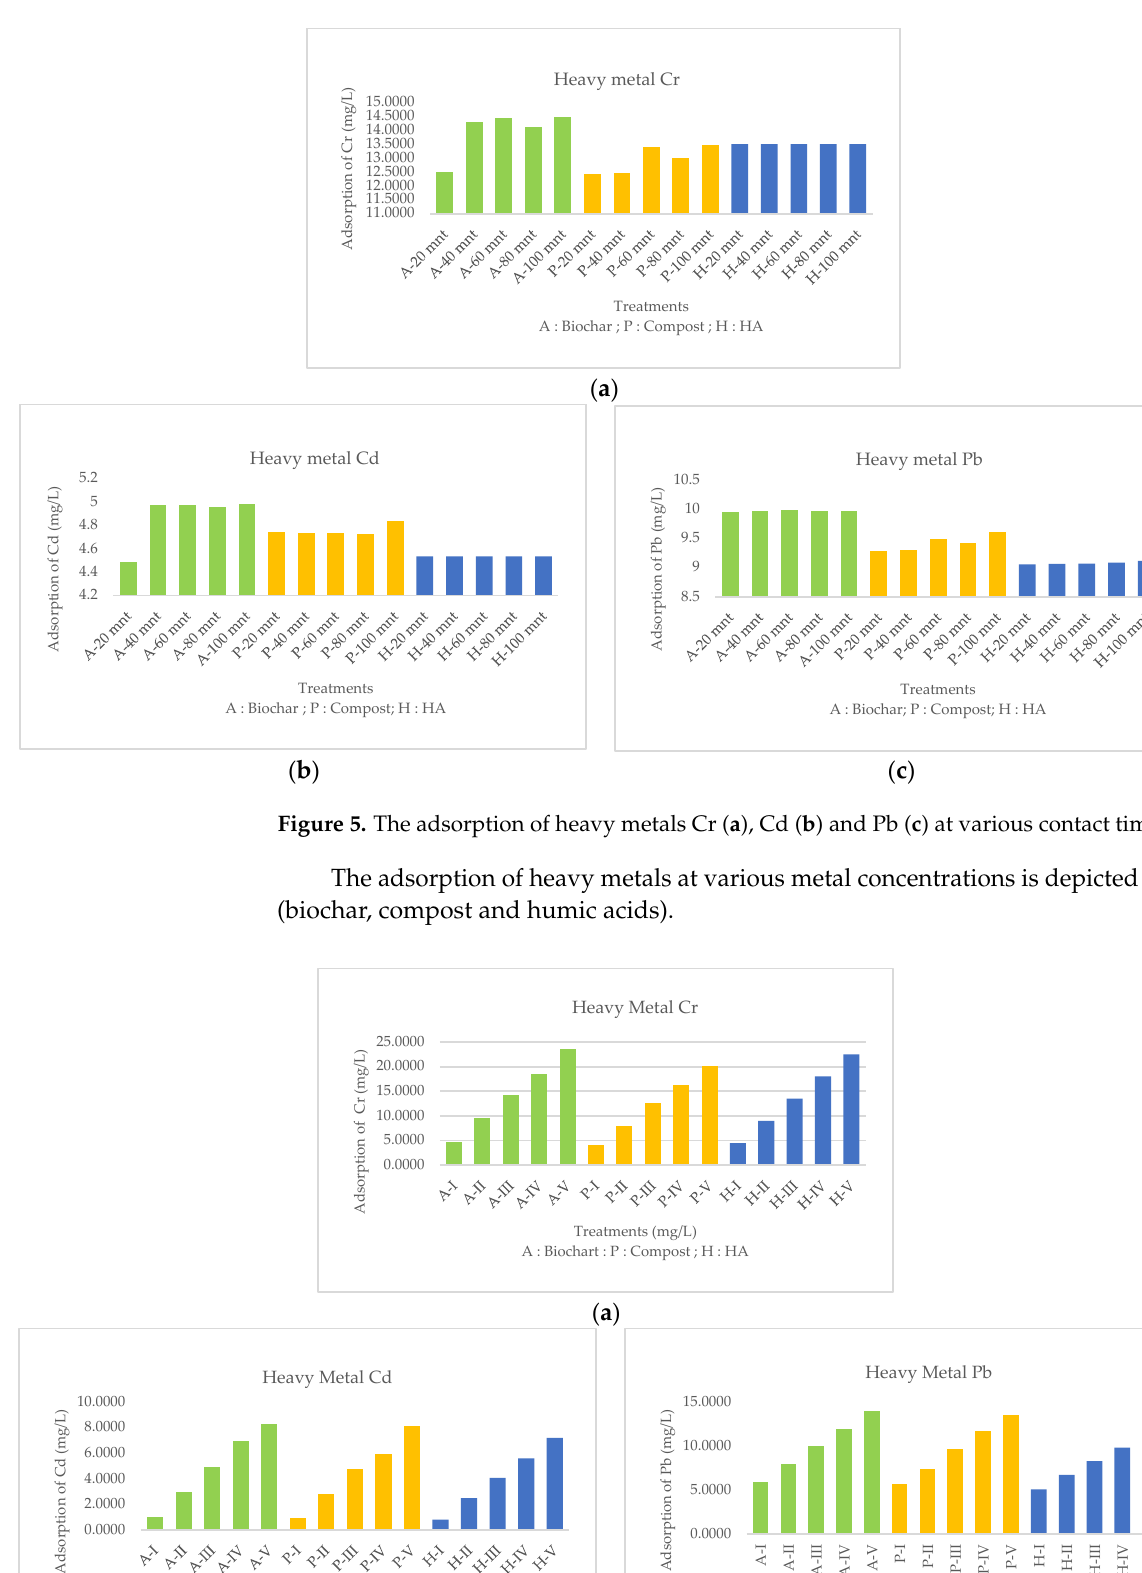
Figure 4. The adsorption of heavy metals Cr ( a ), Cd ( b ) and Pb ( c ) at various weights of adsorbent. The adsorption of heavy metals at varied contact times during each 120 min treat- ment is depicted in Figure 5 (biochar, composts and humic acids).